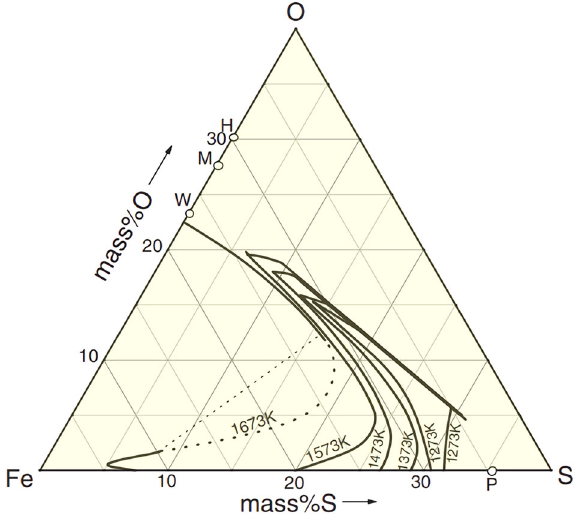
Fig. 2 Phase diagram for the Fe-S-O system. Solid line and dotted line are liquidus and miscibility gap. Point W, point M, point H and point P stand for FeO, Fe 3 O 4 , Fe 2 O 3 , and FeS, respectively 38